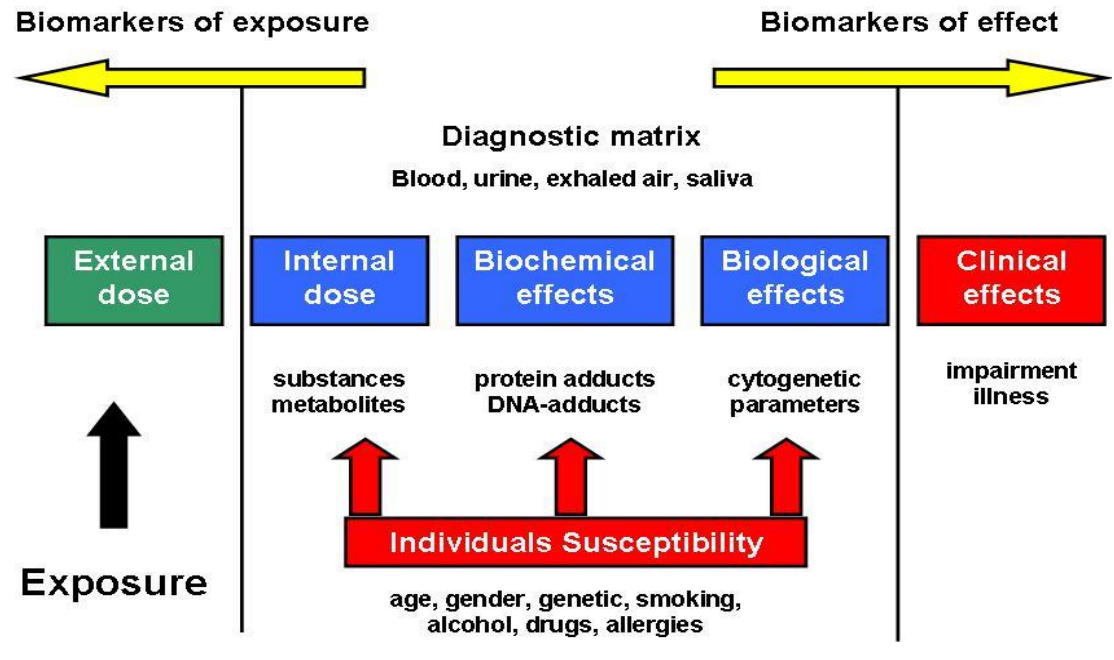
Figure 2. Simplified flow chart of classes of biomarkers